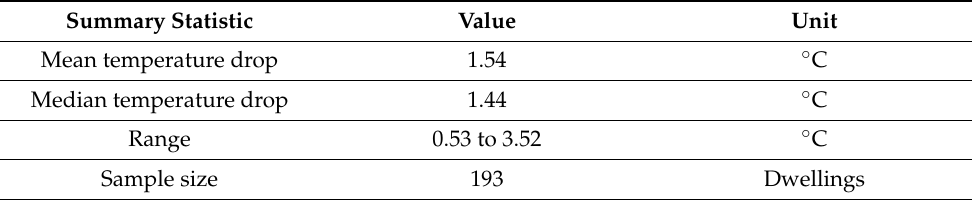
Figure 4. Temperature drop (over three hours, at internal-external temperature difference of 15 ◦ C.) for all valid homes in IDEAL dataset. Table 2. Summary of temperature drop outcomes (over three hours, at internal-external temperature difference of 15 ◦ C) for all valid homes in IDEAL